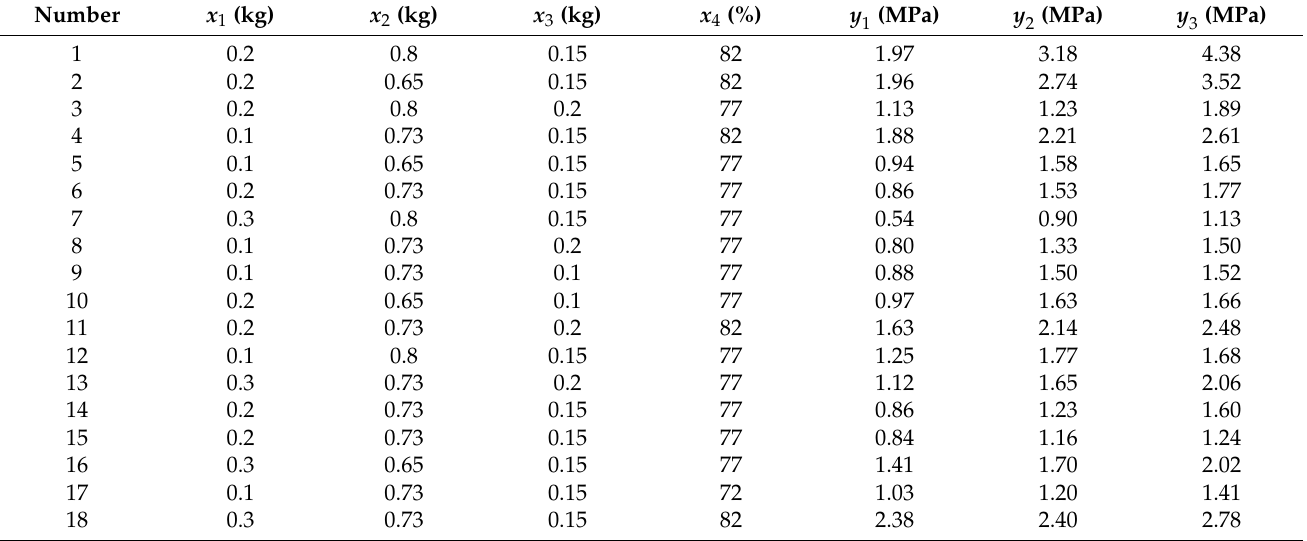
Table 3. Experimental factor range